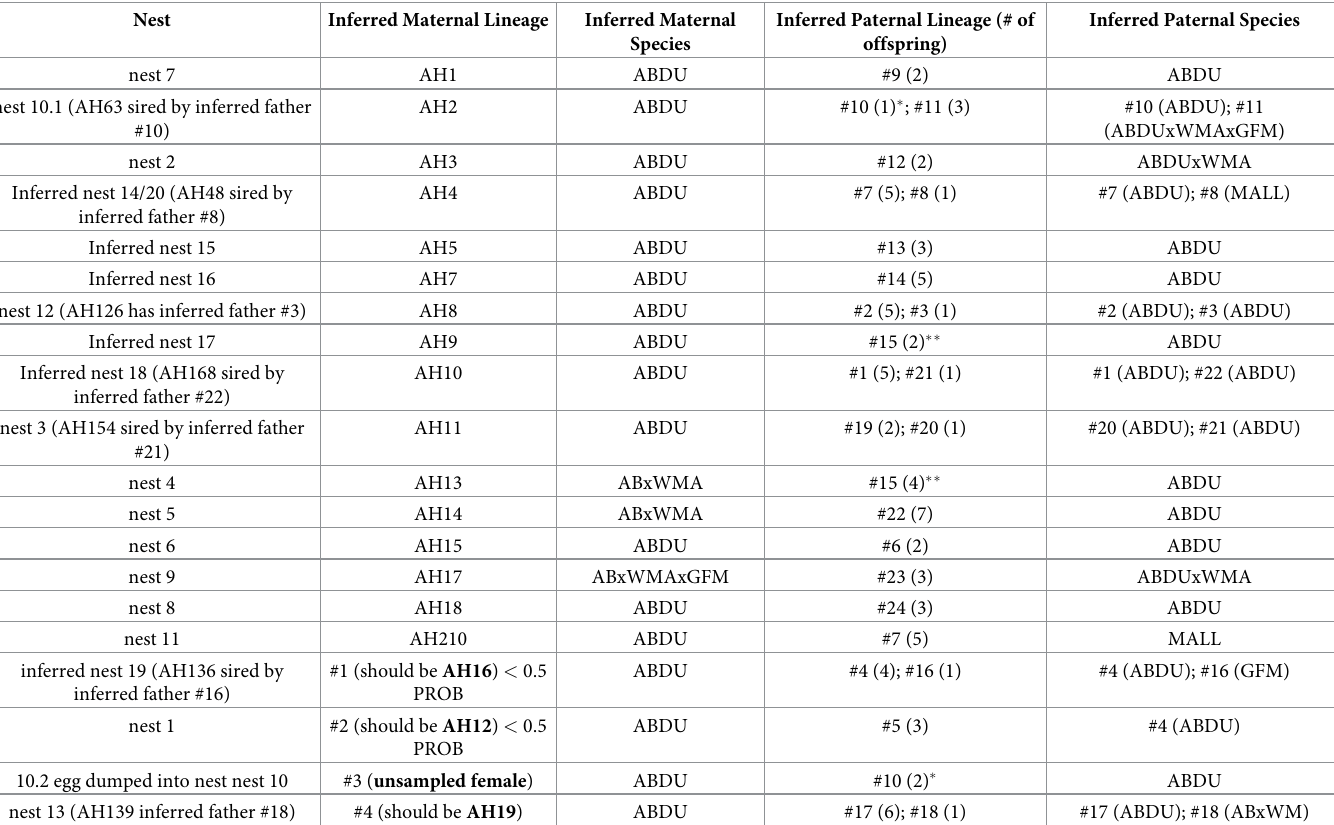
Table 1. Inferred maternal lineages and their associated paternal lineages that explain the genetic diversity of each brood as determined in the program COLONY are provided. Maternal species identity was inferred from their respective ADMIXTURE assignment probability (Fig 3). Paternal species identity was inferred through comparing the maternal and offspring ADMIXTURE assignment probabilities as any differences are the result of different paternal and maternal lineages. The number of sampled eggs that are explained by the pairing across broods are provided in parenthesis next to the inferred paternal lineage. Paternal lineages found in more than one pairing are denoted with asterisk. Note species’ identities included American black duck (ABDU), wild mallard (WMA), and game-farm mallard (GFM) (also see S1 Table for sample specific